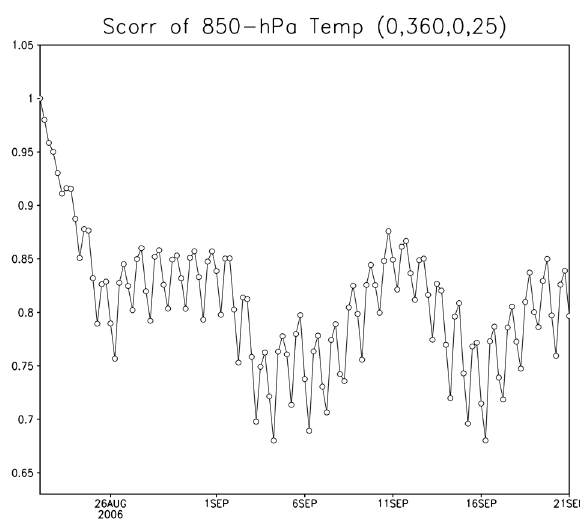
Figure 10. Correlation coe ffi cients between the simulated 850 hPa temperature and the corresponding NCEP analysis over the domain longitude 0 ◦ E to 360 ◦ E and latitude 0 ◦ N to 25 ◦ N over the 30-day period. The choice of a global belt domain for verification is due to zonally-moving weather systems. Correlation coe ffi cients are calculated with the scorr function provided by the Grid Analysis and Display System (GrADS). It should be noted that the correlation coe ffi cients for the 850 hPa temperatures above are 0.65 for the entire 30-day period. Data are from the supplemental materials in